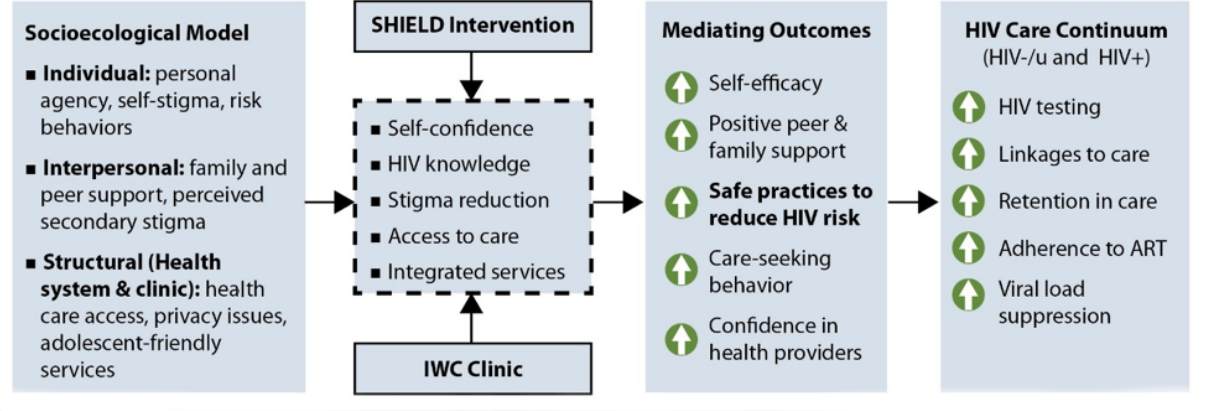
Figure 1. Conceptual framework for creating a comprehensive care continuum for HIV-affected adolescent girls and young women. HIV-/u: HIV-negative or unknown; SHIELD: Support for HIV Integrated Education, Linkages to Care, and Destigmatization; IWC: integrated wellness care; ART: antiretroviral